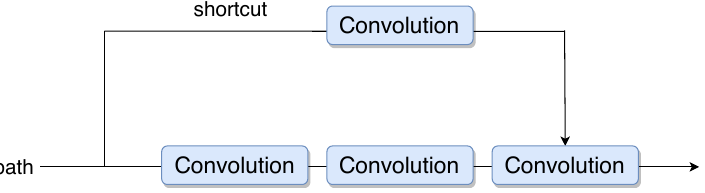
Figure 6. ResNet convolutional block.